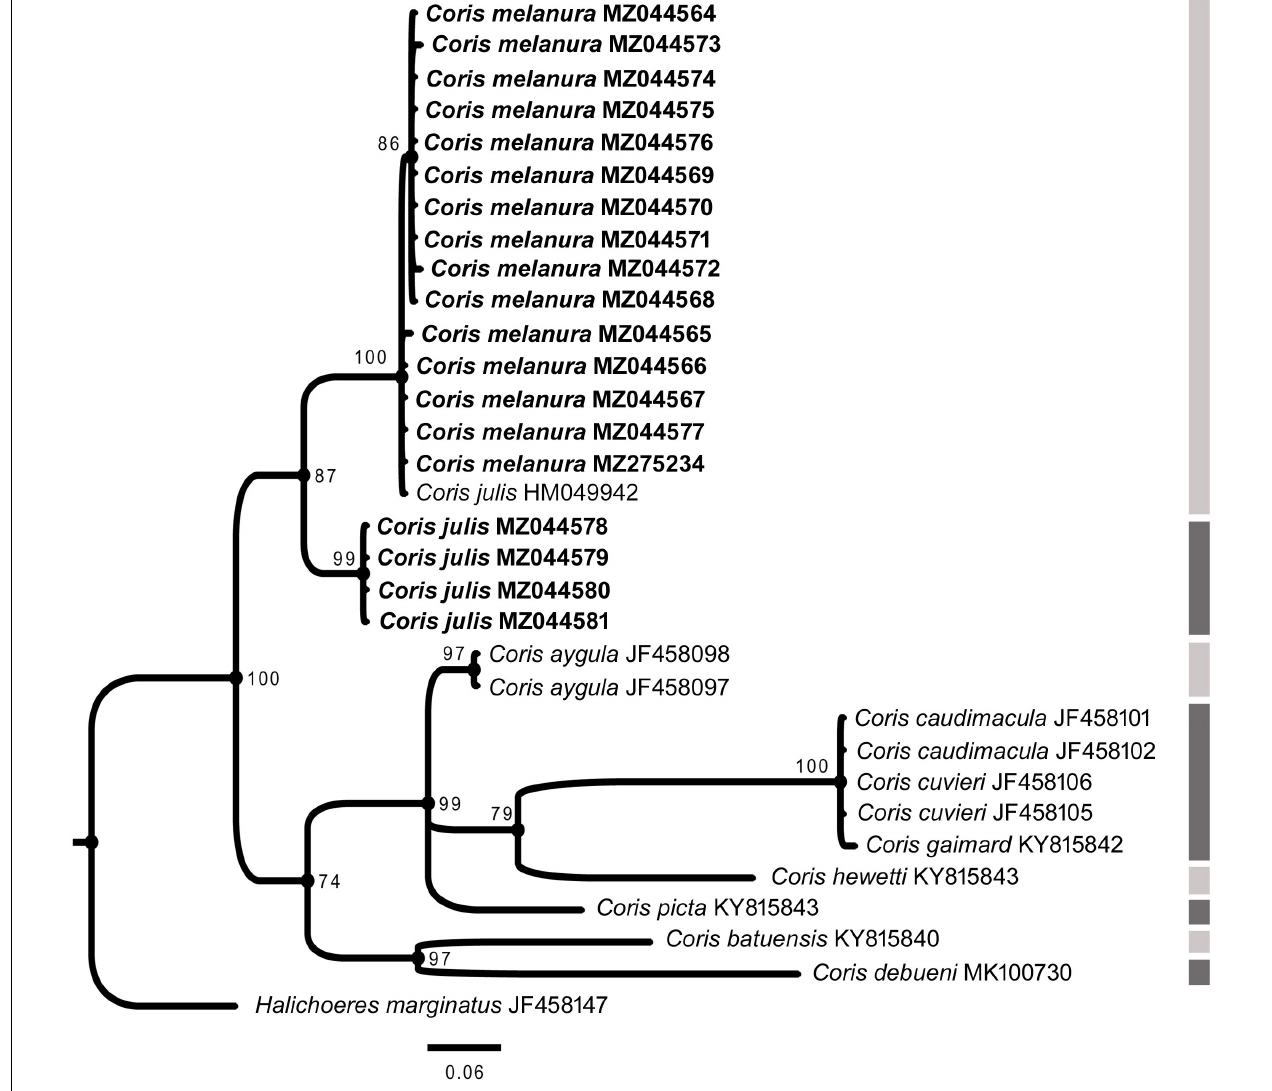
FIGURE 8 | Phylogenetic relationship based on Bayesian Inference (BI) for CYTB fragment for Coris species. Posterior probabilities (%) and GenBank accession numbers are indicated near the nodes and the species name, respectively. Species delimitation analysis using Poisson Tree Process (bPTP) is indicated by lateral dark and light gray side bars. The samples analyzed here are indicated in